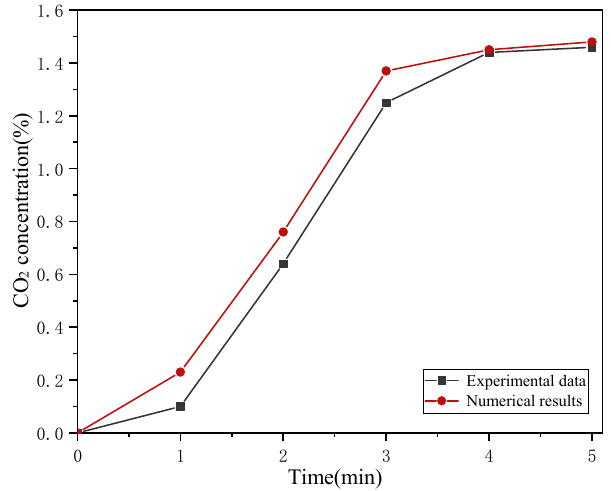
Figure 8. Comparison of the experimental and numerical results.